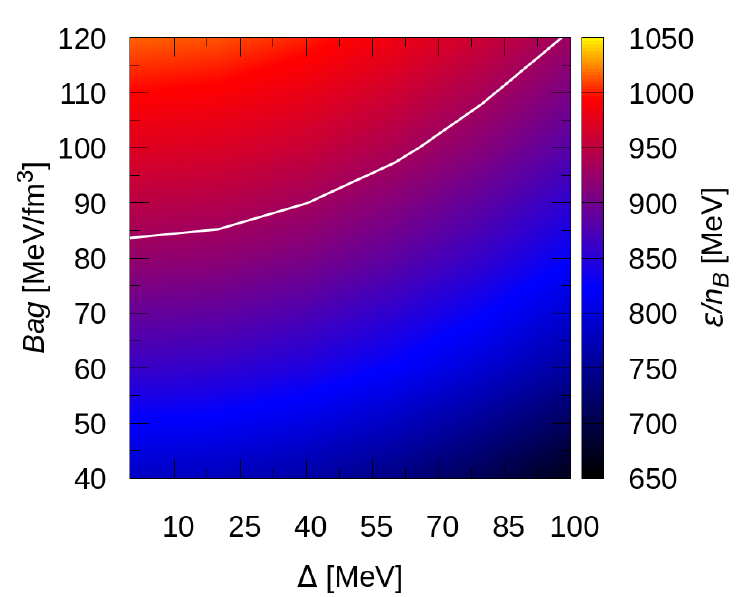
Figure 2. Energy per baryon, ε / n B , as a color map in the Bag – ∆ plane considering a low and constant MF, B = 10 12 Gauss. The white curve indicates the constraint corresponding to the mass of 56 Fe. Only Bag – ∆ pairs below the white curves lead to stable